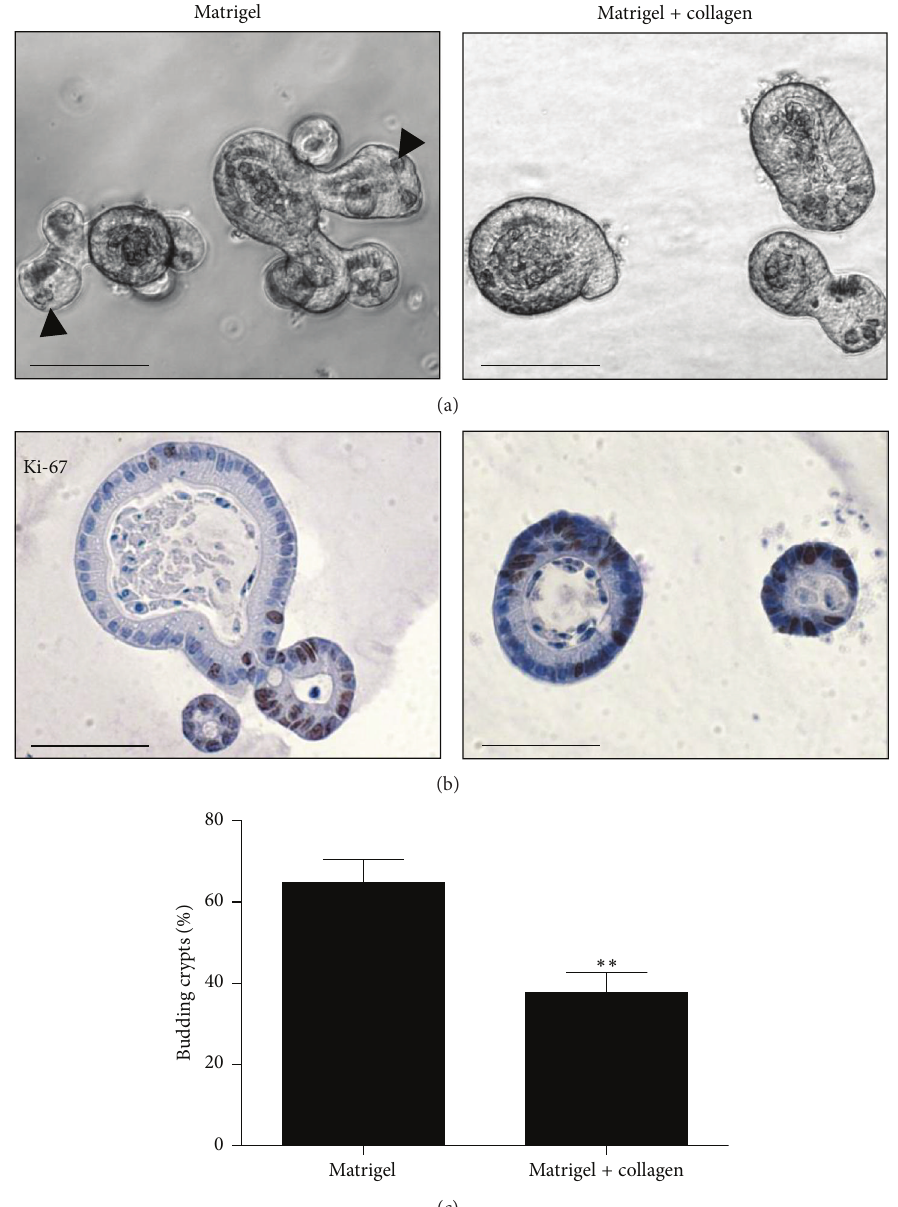
Figure 4: Collagen modulates the phenotype of small intestine organoids. (a) Morphology of small intestine organoids cultured in the presence of EGF, Noggin, and R-Spondin. Arrowheads indicate buds. Scale bar, 100 𝜇 m. (b) Ki-67 staining of small intestine organoids, scale bar, 50 𝜇 m. (c) Collagen reduces budding of small intestine organoids. In total 1700–1800 crypts were quantified per condition. 𝑃 = 0.0045 , two-tailed 𝑡